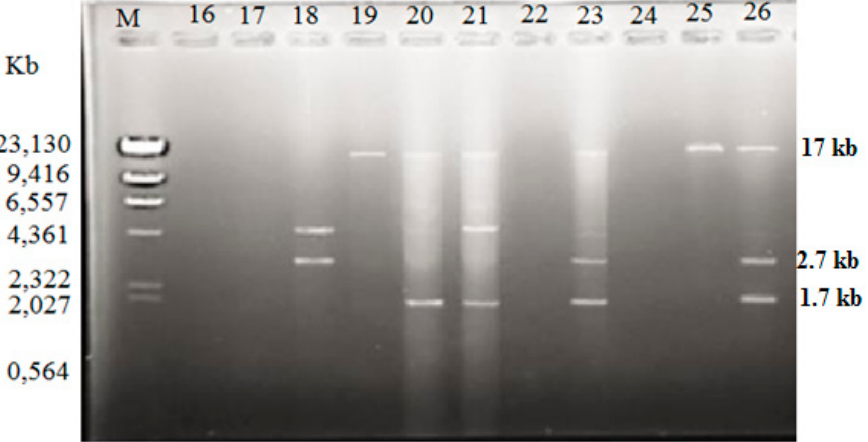
Figure 2. Example of plasmid profiles of Vibrio vulnificus isolated from Qatar (strain 32–37, Malaysia; strain 38–46, Qatar) using a PureYield™ Plasmid Miniprep System on 1% ( w / v ) agarose gel. Lane M: Lambda DNA-HindIII Digest DNA ladder. Lane 47–60: V. vulnificus strain 47–60; NC: negative control.